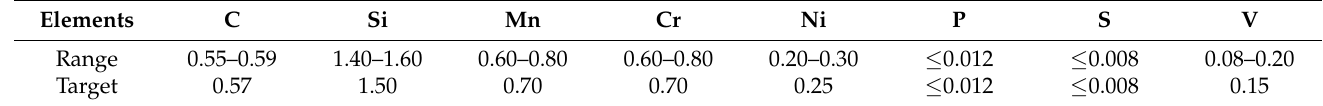
Table 1. Chemical compositions of the 55SiCr spring steel (wt.%) used in this experiment. Elements